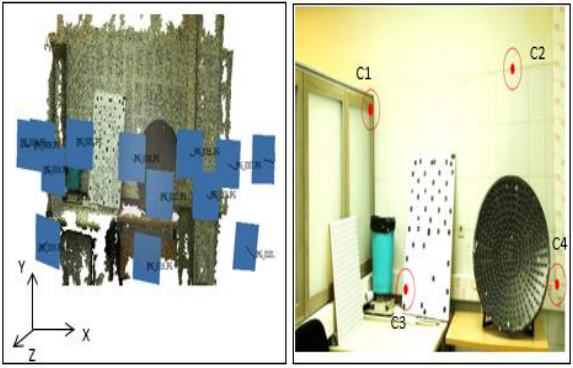
Figure 3. test scene (left) and check points location